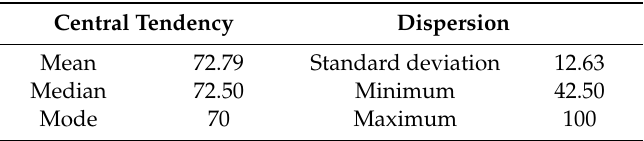
Table 1. Main measures of the central tendency and dispersion of the distribution described by the computed partial SUS